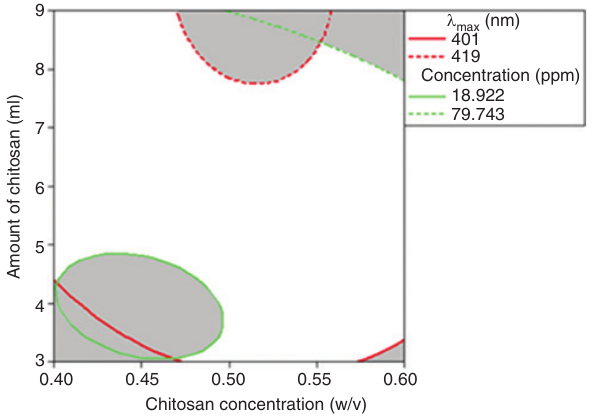
Figure 8: Transmission electron microscopy (TEM) image of the max synthesized silver nanoparticles (AgNPs) at obtained optimum